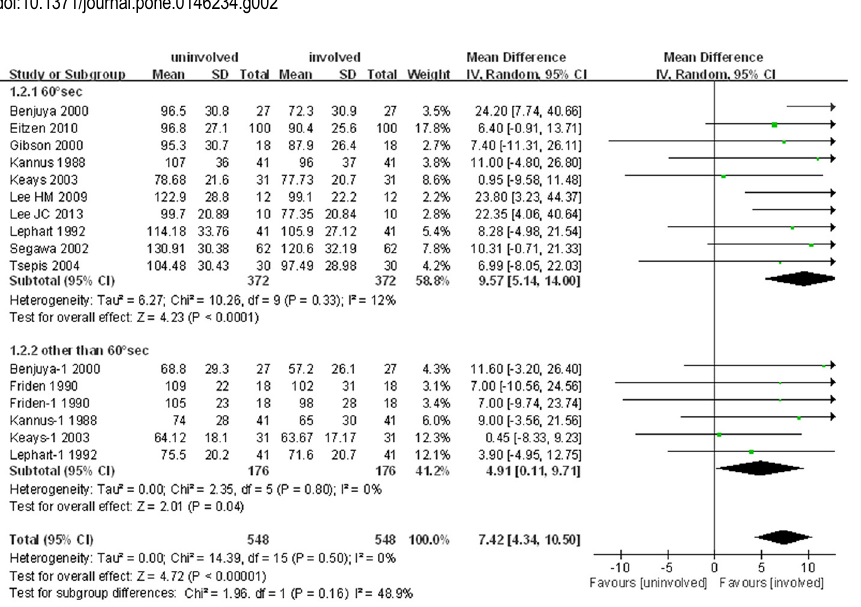
Fig 2. Forest plot demonstrating significant reductions in quadriceps strength in ACL deficient limbs compared with uninjured limb.